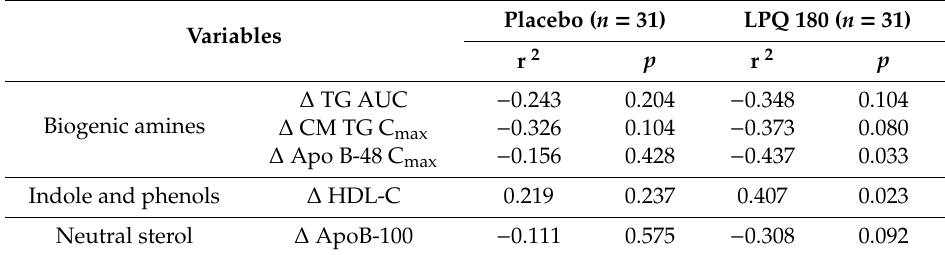
Table 5. Correlation between baseline levels of fecal metabolites and changes in blood lipid markers for 12 weeks 1